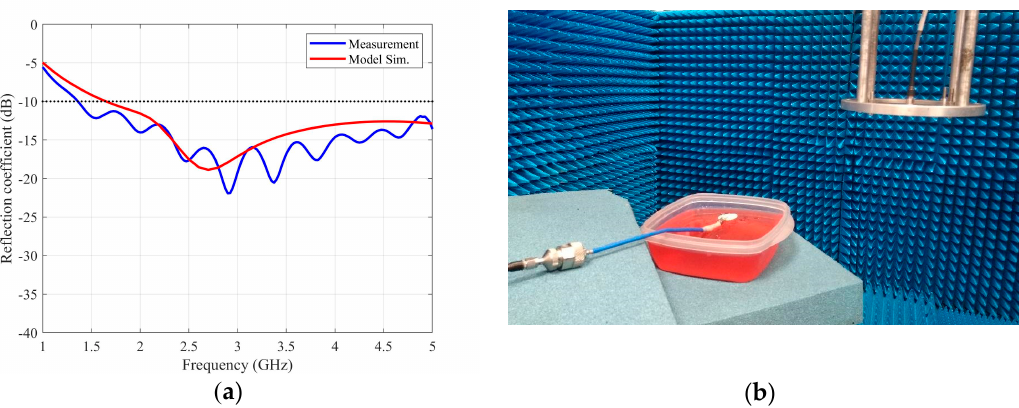
Figure 10. ( a ) Measurement and simulation of the reflection coe ffi cient of the antenna under test Figure 10. (a ) Measurement and simulation of the reflection coefficient of the antenna under test ( b ) ( b ) Back radiation measurement set-up. Back radiation measurement set-up.